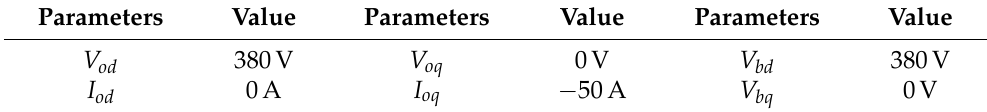
Table 2. The operating point values of MG.